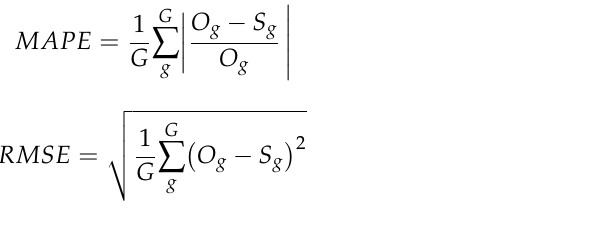
Table 1. Nomenclature for variables and